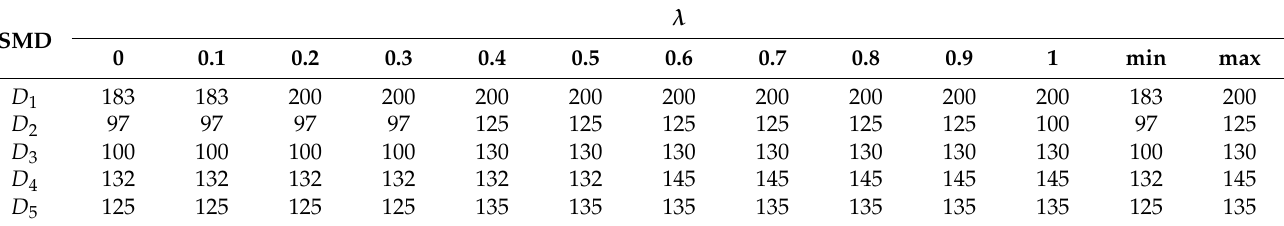
Table 15. The total number of SMD types for each value of the λ